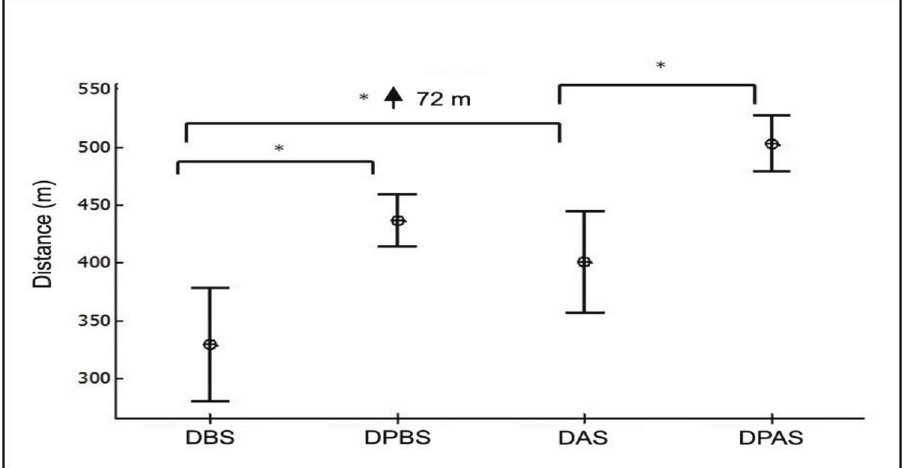
Figure 2 - Distance on ISWT in preoperative and postoperative phases and predicted distance. DBS= distance before surgery; DPBS = distance predicted before surgery; DAS = distance after surgery; DPAS = distance predicted after surgery. * p p 0.05 compared DBS vs DPBS; DBS vs DAS and DAS vs DPAS.